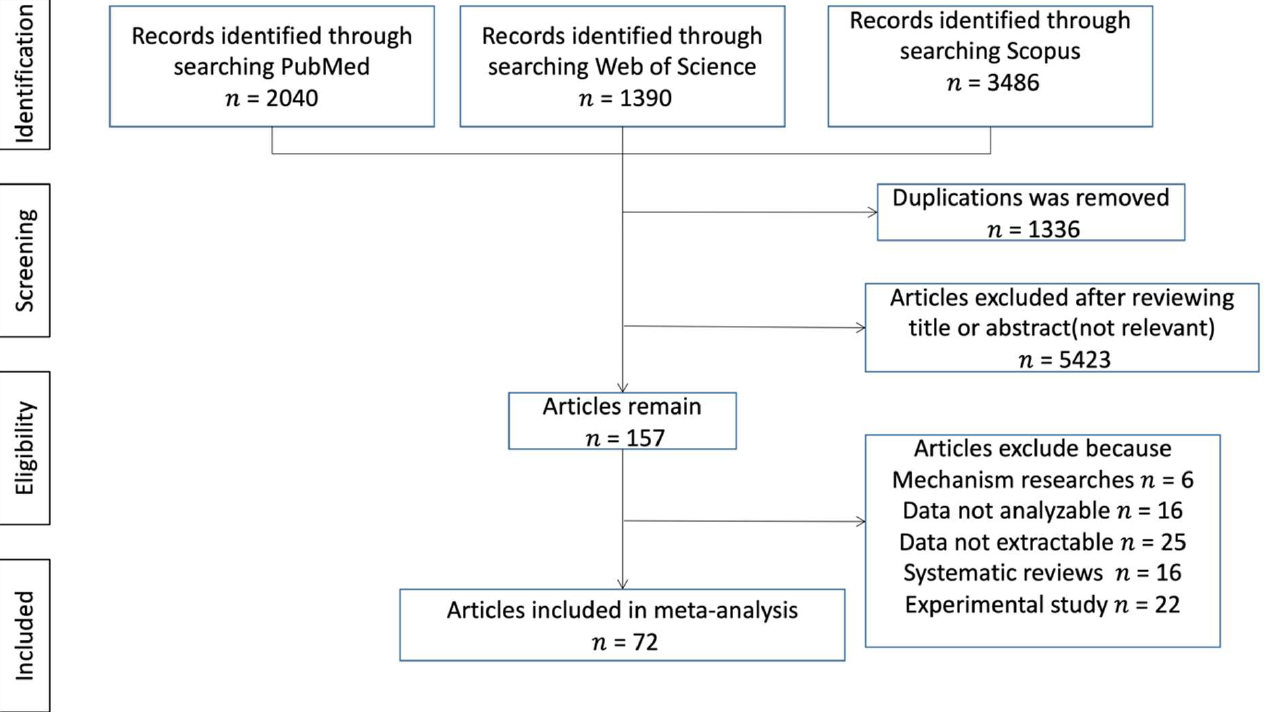
Figure 1. Flow diagram of the literature search.